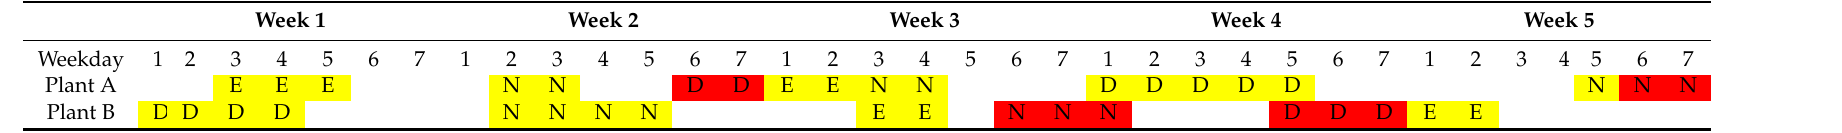
Table 1. A standard five-week shift plan for Plant A and B.